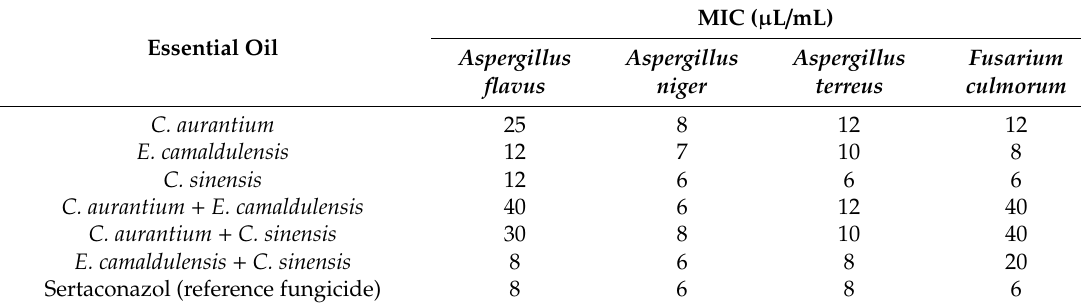
Table 6. Minimum inhibitory concentrations (MICs) of the essential oil